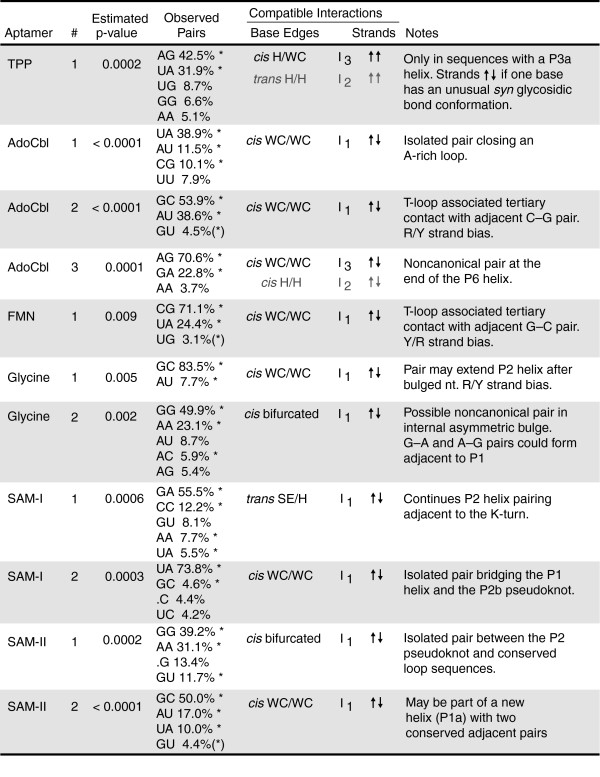
New base-base interaction predictions. For each numbered and asterisked prediction in Figure 5 the statistical significance (p value) of the mutual information between the two alignment columns is shown, followed by the relative frequencies with which specific combinations of bases are observed in those columns. Base pair geometries and isostericity groups compatible with the asterisked pairs are described in more detail elsewhere [75]. These descriptions include the relative orientations of the glycosidic bonds across the pair (cis or trans), the edges of each base that interact (WC, Watson-Crick; H, Hoogsteen; SE, sugar edge; bifurcated, intermediate between two edges), and the relative backbone strand geometry (parallel or anti-parallel) assuming both glycosidic bonds are in default anti conformations.